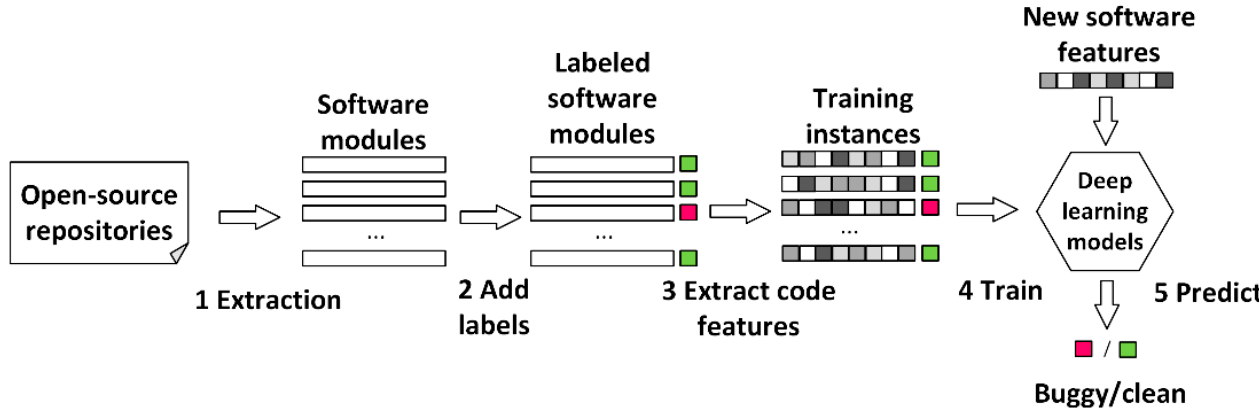
Figure 1. Workflow of deep learning based software defect prediction.